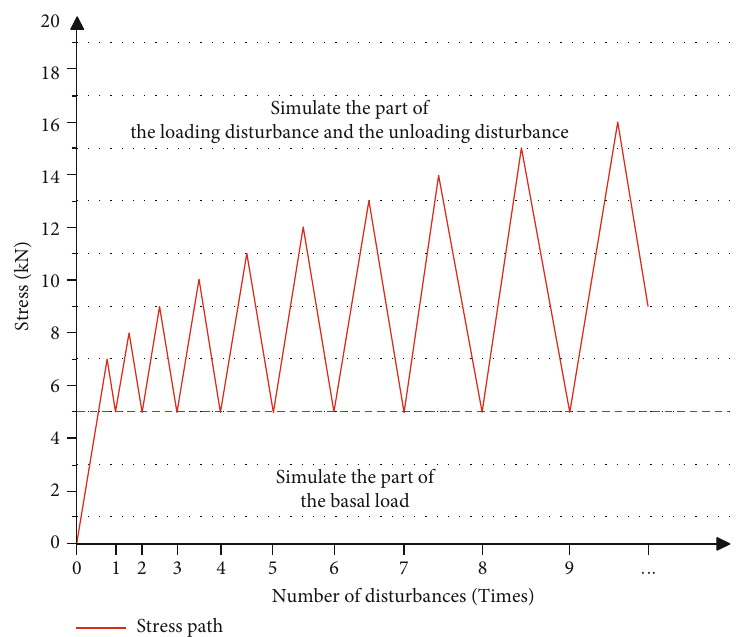
Figure 1: Diagram of the loading and unloading